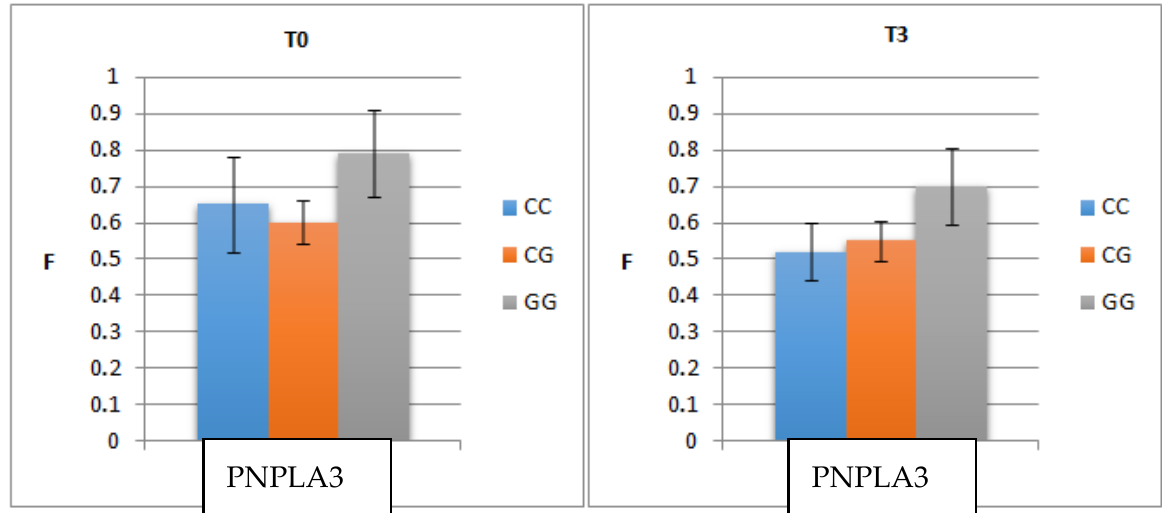
Figure 1. Correlation of pre- and post-treatment fibrosis (three months post-SVR)with PNPLA3 genotype. T0 — the initial visit; T3—the second visit; PNPLA3—patatin-like phospholipase domain-containing3; F—fibrosis. The mean level of S pre-treatment did not significantly differ depending on PNPLA3 genotype (0.51; 0.48; 0.52; p = 0.738), and the lack of correlation was maintained